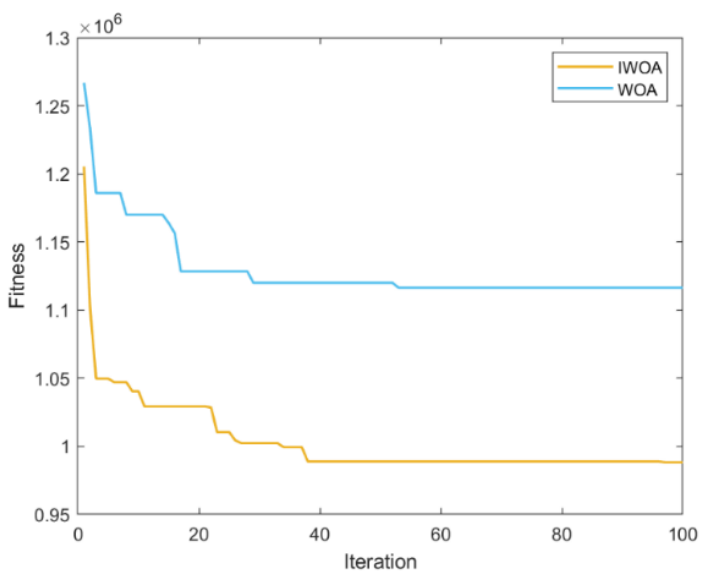
Figure 24. Convergence curve.